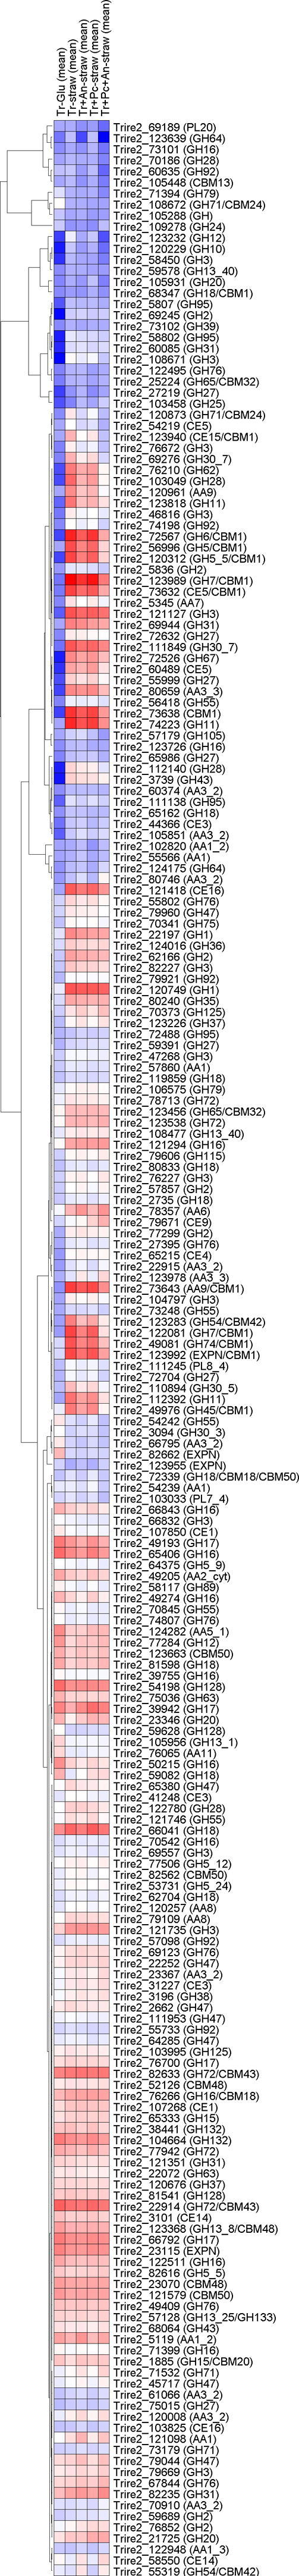
High resolution image of the hierarchical clustering of the T. reesei CAZy genes from Fig.8(A).